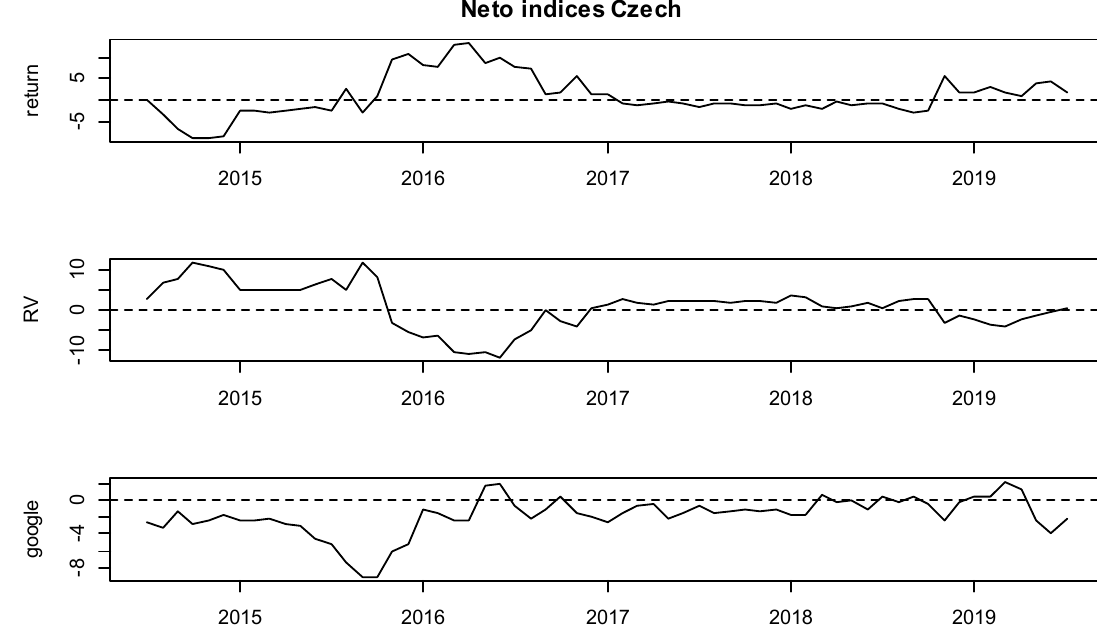
Figure 12. Net rolling indices, the Czech Republic.